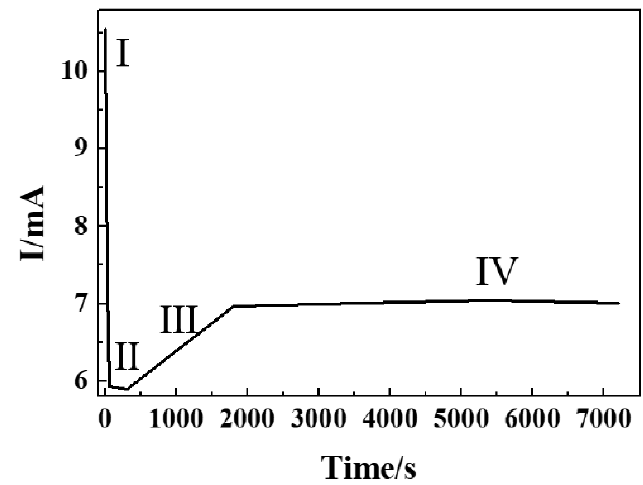
Figure 2. I-t curve during anodization of Nb in 0.4 M NH 4 F containing glycerol electrolytes at 20 V.